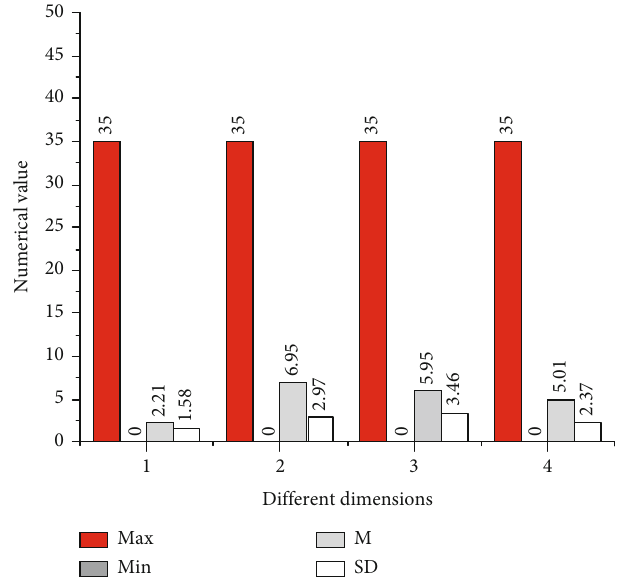
Figure 3: Descriptive statistical results of personality traits (1: psychoticism; 2: introversion-extroversion; 3: neuroticism; 4: concealment).